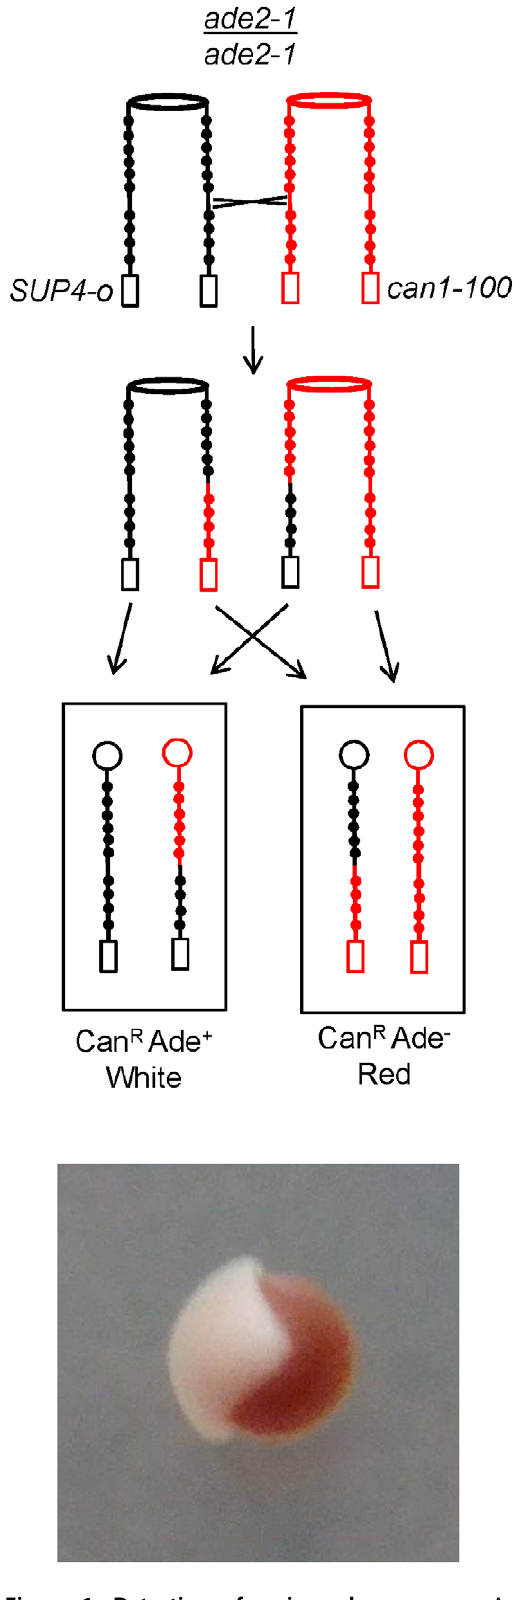
Figure 1. Detection of reciprocal crossovers. A reciprocal crossover (RCO) in G2 is shown, with chromatids indicated by vertical lines, the centromeres as ovals, and heterozygous polymorphisms